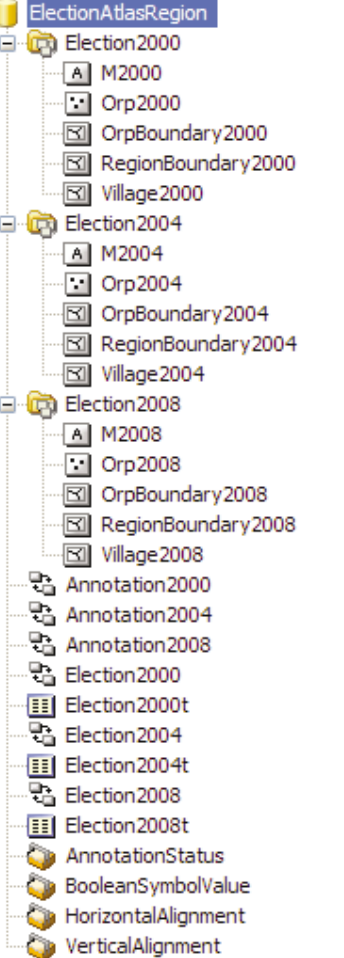
map layer, the text positions were the same on all maps.